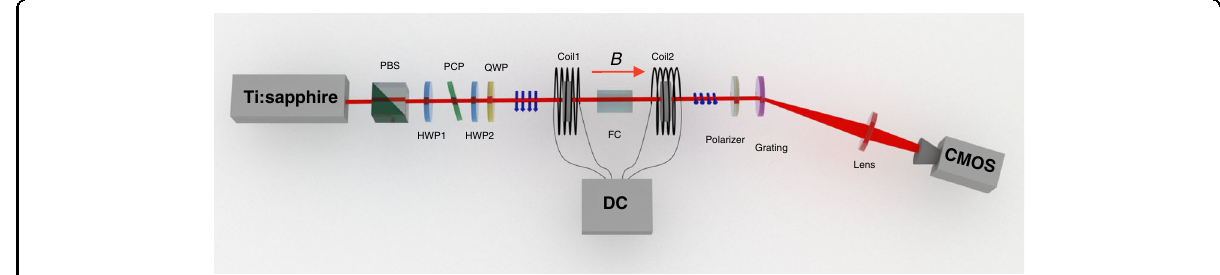
Fig. 2 Experimental setup to sense static magnetic fi eld with CM, SWM, and BWM schemes. A pulsed laser centering at λ 0 = 796 nm is horizontally polarized ( j H > ) after passing through a polarized beam splitter and then rotated to be 45° diagonal polarized ( j H þ V > ) by a half-wave plate (HWP). The phase compensation plate introduces a biased phase between the j H > and j V > components, which are transformed to j R > and j L > after passing through HWP and the quarter-wave plate (QWP). A Faraday crystal (FC) placed between two electric coils introduces a relative phase between j R > and j L > that is proportional to the magnetic induction strength B . Both projective measurement in CM and post-selecting in SWM and BWM are implemented using a polarizer. By dispersing the beam with a grating, both the change of photon numbers and spectrum redistribution are recorded by a CMOS, and B can be determined from the corresponding spectrum